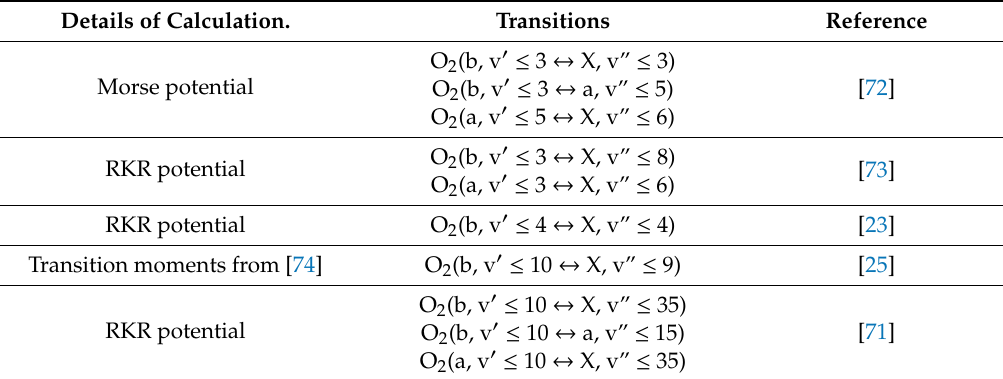
Table 4. Calculations of Franck–Condon factor